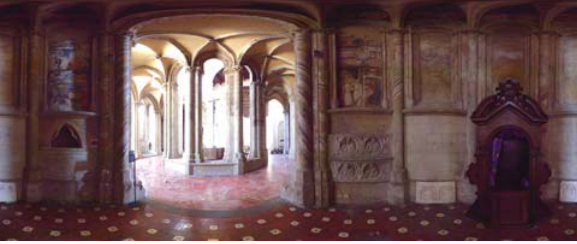
Figure 3. Mapping Gothic France. High resolution equirectangular projection from database.